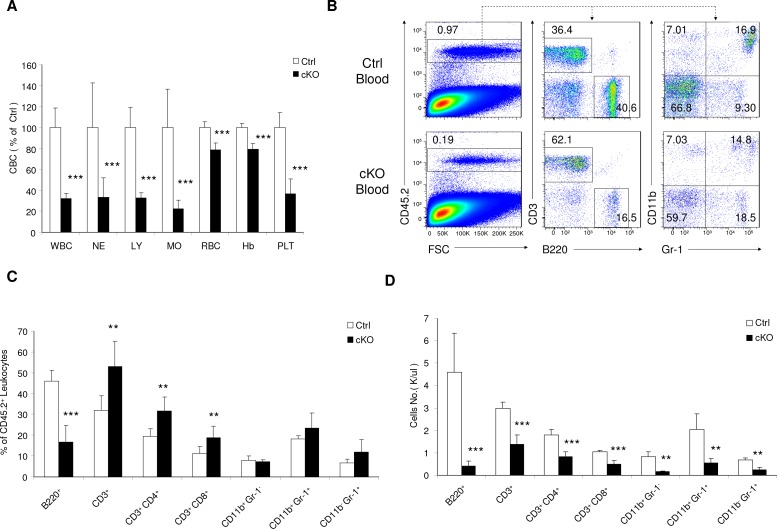
Rptor cKO mice are pancytopenic.(A) Complete blood cell counts (CBC) data for Ctrl and cKO mice on day 30 after pIpC treatment. WBC, white blood cells; NE, neutrophils; LY, lymphocytes; MO, monocytes; RBC, red blood cells; Hb, hemoglobin; PLT, platelets. Means of the Ctrl mice in each experiment are artificially defined as 100%. (B) Representative FACS profiles showing the percentages of different leukocyte populations in peripheral blood from Ctrl and cKO mice on day 30 after pIpC treatment. (C, D) Reduction of leukocyte populations in the peripheral blood of cKO mice. Frequencies among CD45.2+ leukocytes (C) and absolute numbers (D) of various cell types in blood on day 30 after pIpC treatment are shown. n = 7 for Ctrl mice; n = 6 for cKO mice. Data represent one of three independent experiments with similar results.